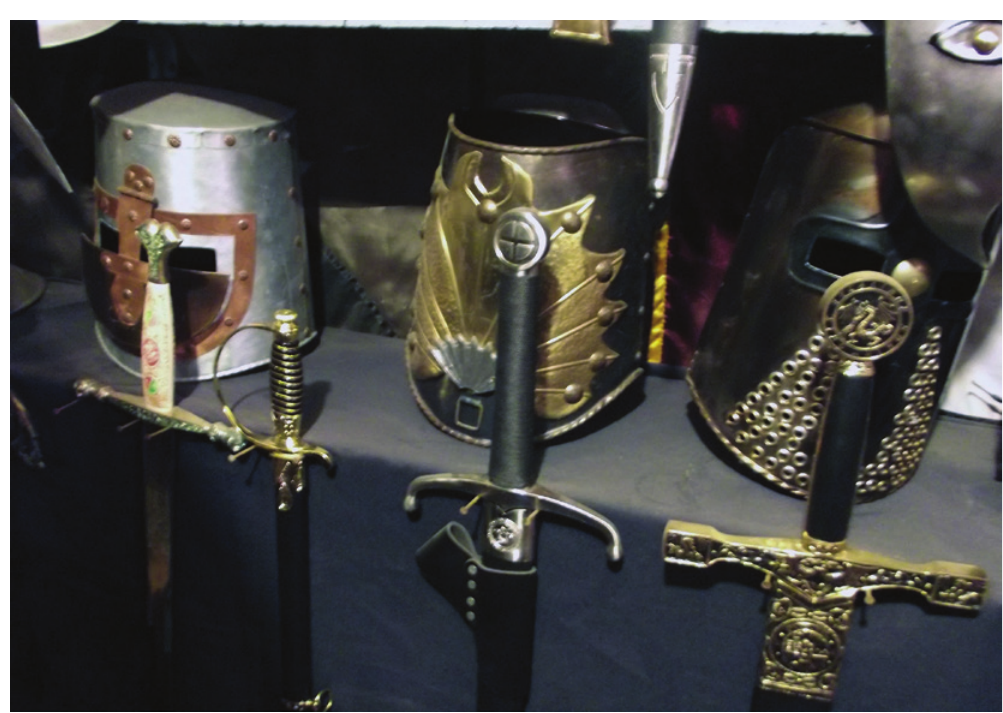
Figure 6: Output research and documentation: Julio González (medieval